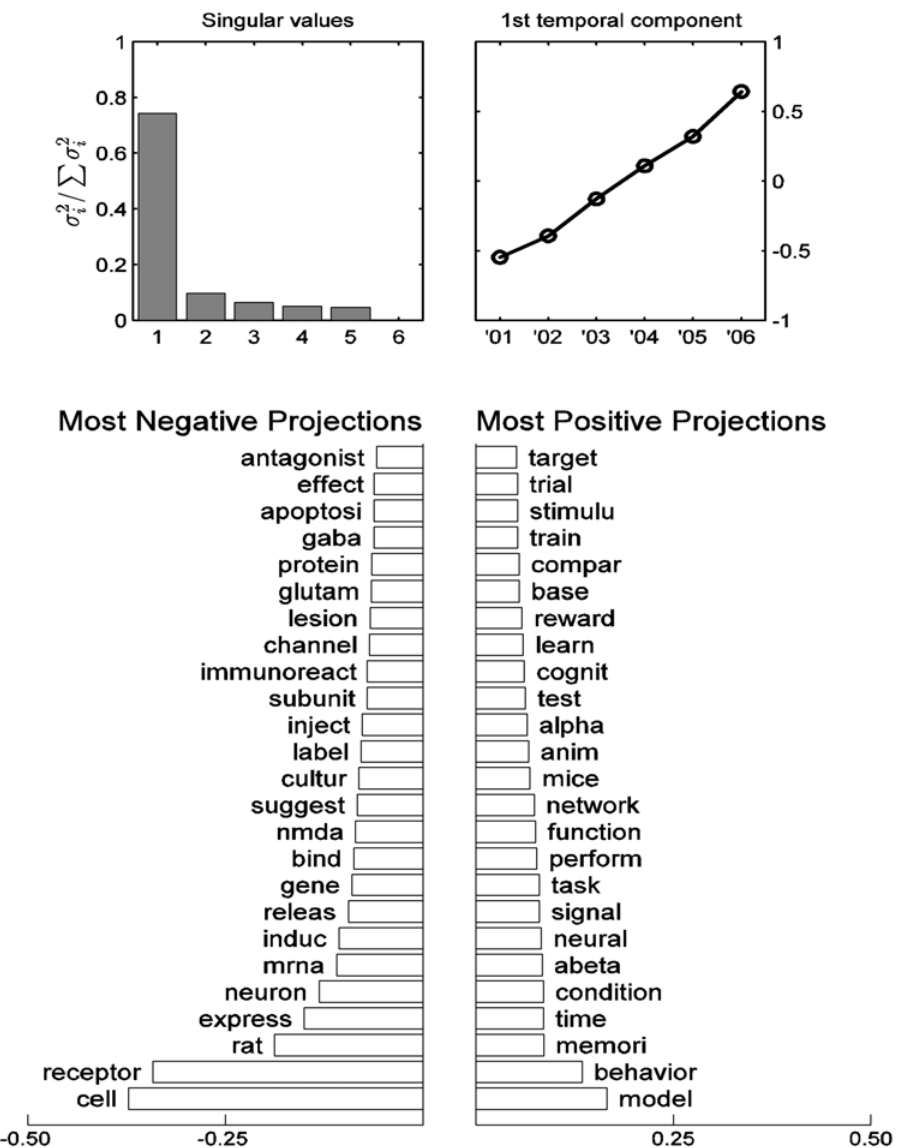
Figure 11. Word-frequency dynamics. Top left: distribution of singular values. The first component accounts for 74.4% of variance. Top right: The first right singular vector (temporal component). Bottom: The most negative and most positive projections of specific words onto the first component. Most positive words are increasing in frequency; most negative words are decreasing.